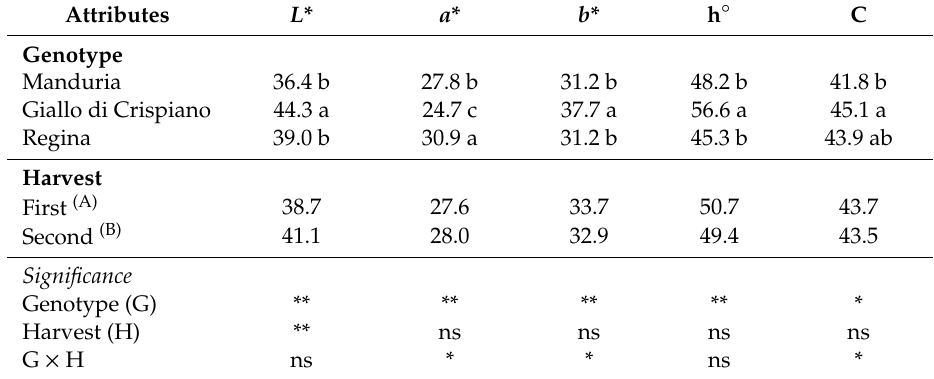
Table 2. Main e ff ects of genotype and harvest time on color parameters ( L *, a *, b *, h ◦ and C) of tomato Table 2. Main effects of genotype and harvest time on color parameters ( L * , a * , b * , h° and C) of tomato fruits.